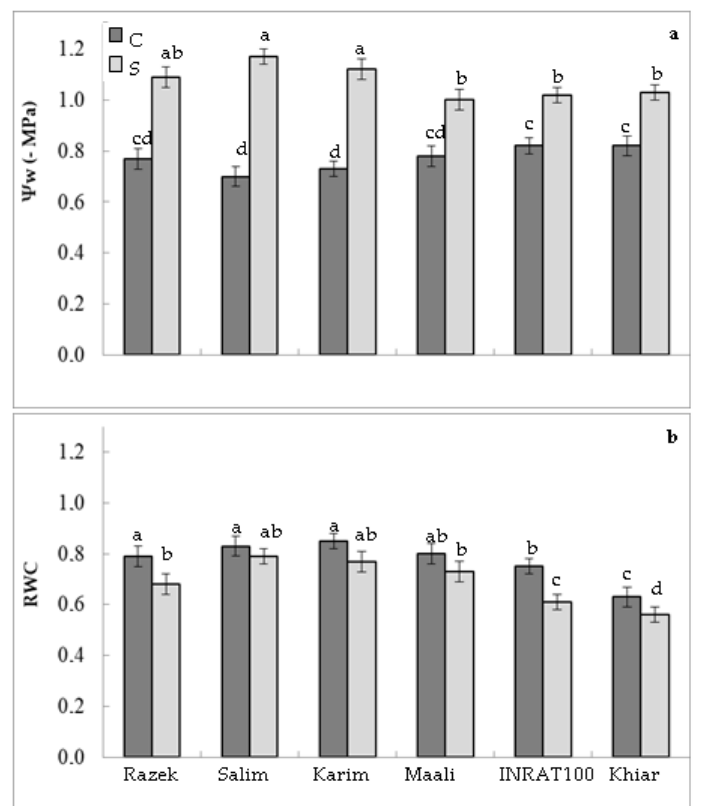
Figure 2. Water potential ( Ψ w, ( a )) and relative water content ( b ) in durum wheat ( Triticum durum Desf.) plants subjected (S, stressed) or not (C, control) to drought stress. According to Fisher’s least significant difference, within columns, means with the same letter are not significantly different at α = 0.05. Standard errors of means of 10 replicates .